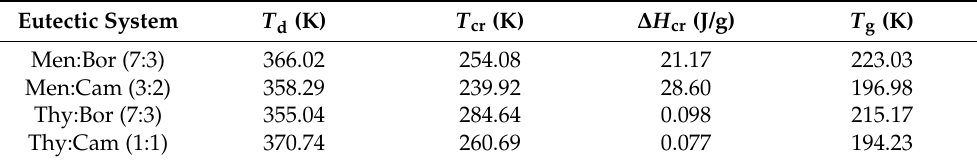
Table 5. Experimental data of the degradation temperature ( T d ), the crystallization temperature ( T cr ), enthalpy of crystallization ( ∆ H cr ), and the glass transition temperature ( T g ) of the eutectic systems. Eutectic